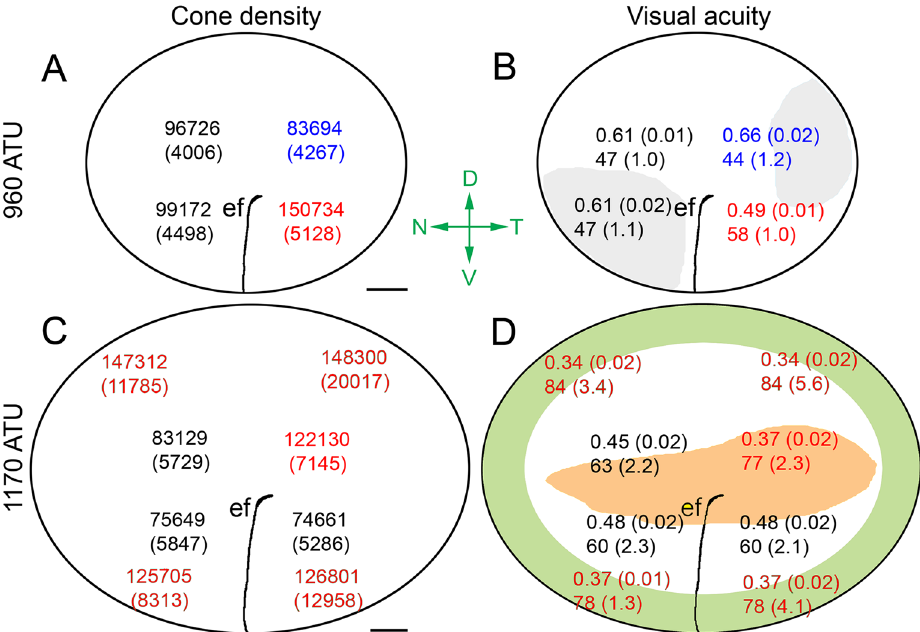
Figure 7. Diagrams illustrating topographic maps of cone densities and visual acuity-related variables extracted from the retinas of four Atlantic halibut at 960 ATU or 1170 ATU. Each statistic is the mean (± SD). ( A , C ) Cone density per mm 2 ; gray zones in ( C ) delineate the approximate areas of square mosaic presence. ( B , D ) Minimum resolvable angle (º) (top number), and distance (in mm) (bottom number) at which a 0.5 mm target would be resolved. The green and pink zones in ( D ) denote the approximate areas associated with the peripheral square mosaic and triple cone presence, respectively. Means with different colour are statistically different at α = 0.05 level of significance. The embryonic fissure (ef) runs from the ventral retina toward the centro-temporal retina. Abbreviations (axes in green): D, dorsal; V, ventral; N, nasal; and T, temporal. Scale bars in ( A ) and ( C ) equal 0.2